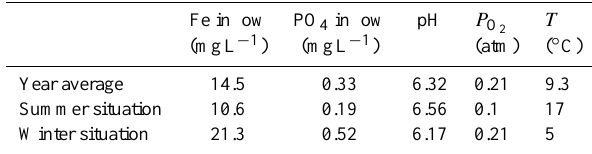
Table 2. Input parameters for the CSTR